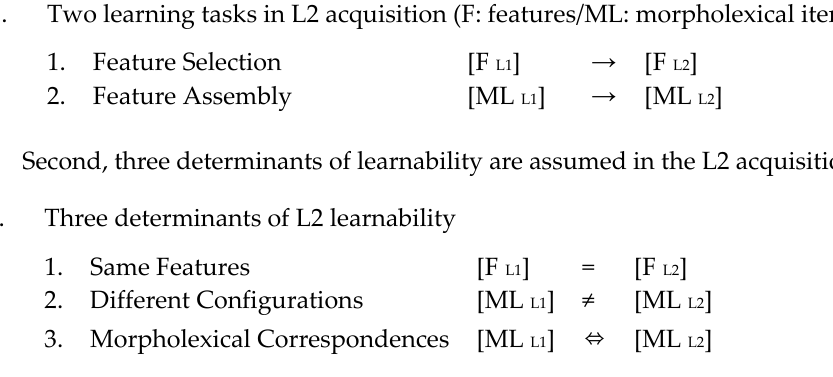
Table 3 encapsulates the two learning tasks (1. Feature Selection; 2. Feature Assembly) and